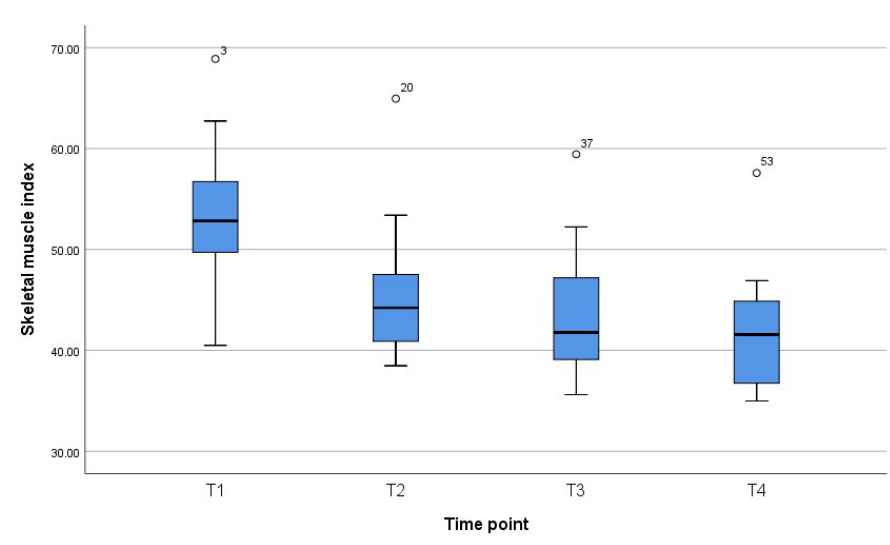
Figure 2. Box plot for SMI for different time points.